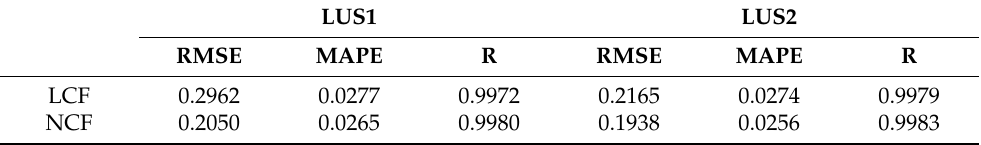
Figure 1. The comparison of two convergence factors. Table 1. Comparison of different improvement strategies on the test samples of S1 subject.